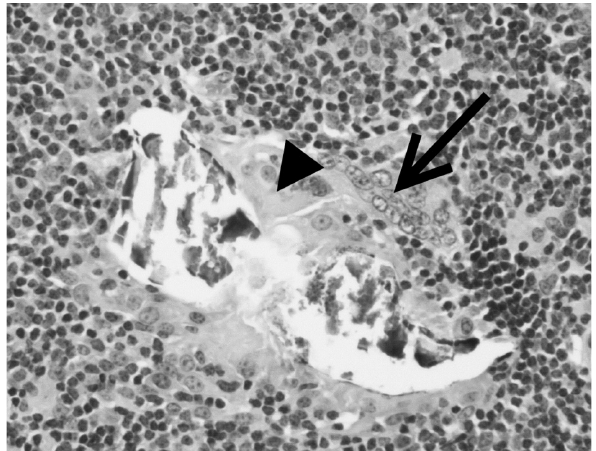
Fig. 3. – Around calcifying parasites fragments, macrophages (arrow head) and giant multinucleated cells (arrow) can be observed, typical of a granulomatous reaction. Surrounding this area, many lymphocytic cells frequently showing mitosis signs are visible (pho- tonic microscope